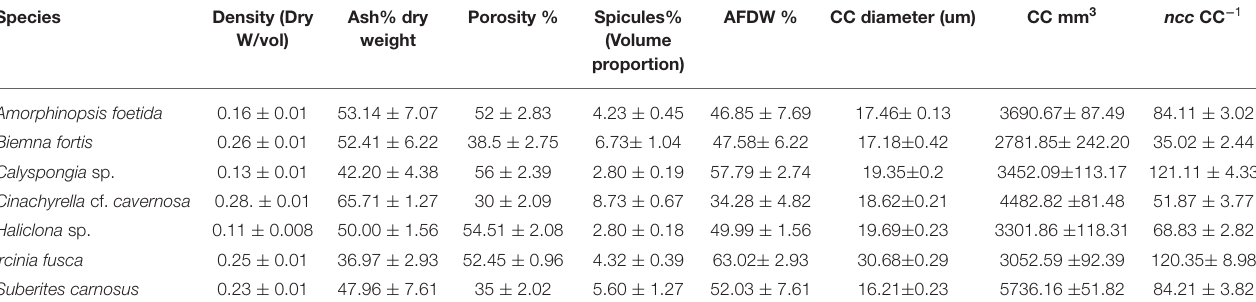
TABLE 3 | Mean values of the structural components and the filtration apparatus of the studied species. Species